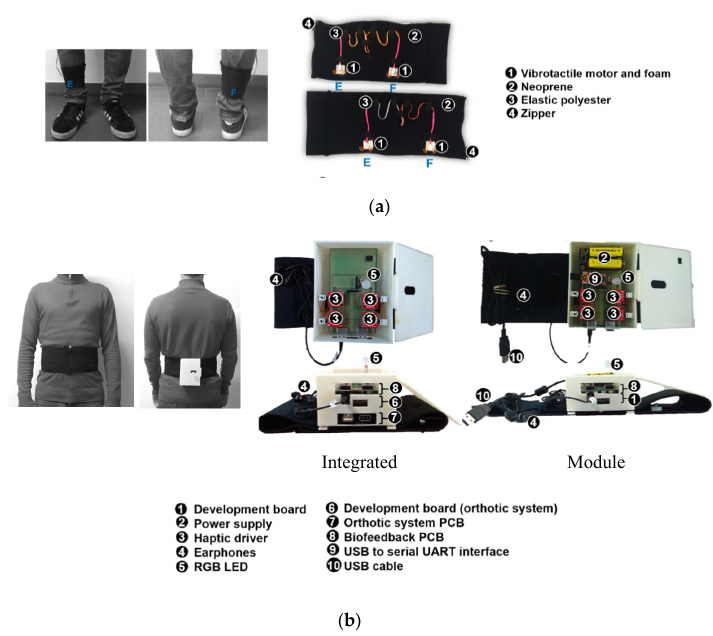
Figure 1 . (a) Vibrotactile shank bands and ( b ) BS components and electronic interfaces when BS is used integrated into or as a module of the ankle-foot exoskeleton.